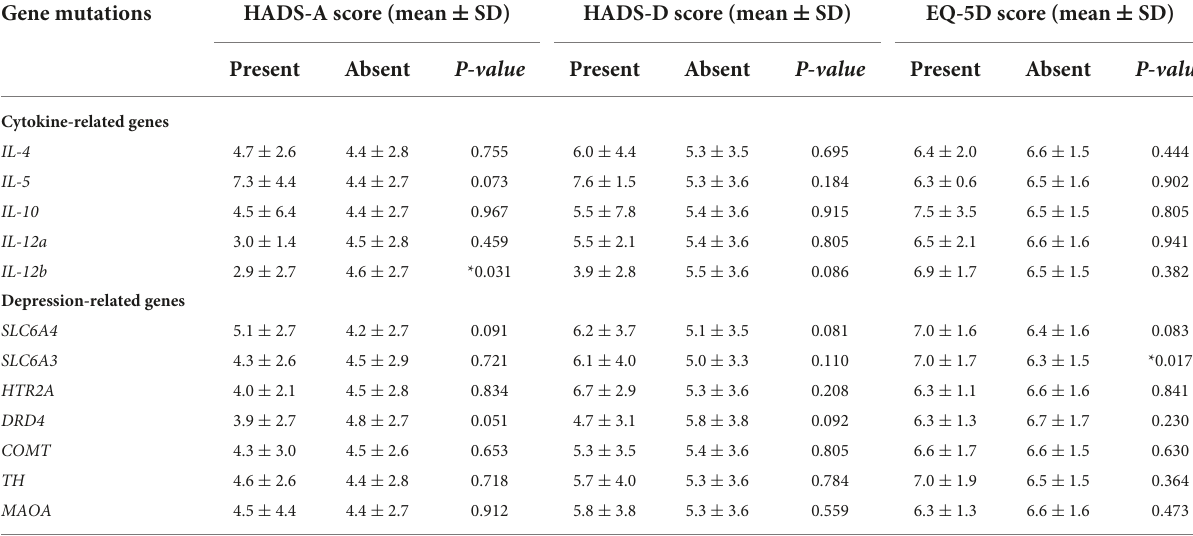
TABLE 5 Associations of cytokine- and depression-related gene mutations with anxiety, depression, and QOL. Gene